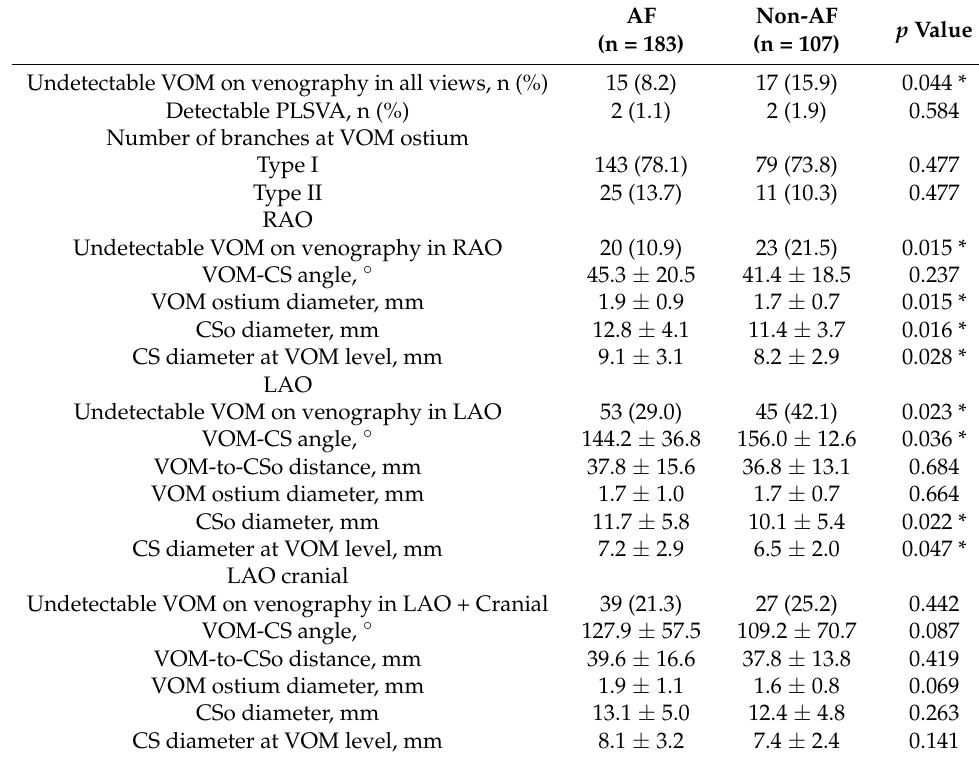
Table 2. Assessment of angiography images.